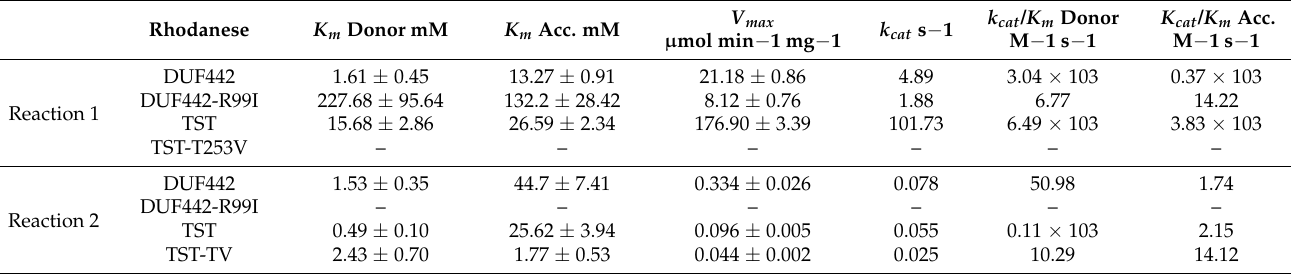
Figure 4. Kinetics of DUF442 and TST-catalyzed Reactions 1 ( A ) and 2 ( B ). The data shown as average ± s.d. are all from 3 independent experiments and fitted with Michaelis-Menten equation. Table 3. Kinetic parameters of DUF442 and TST.